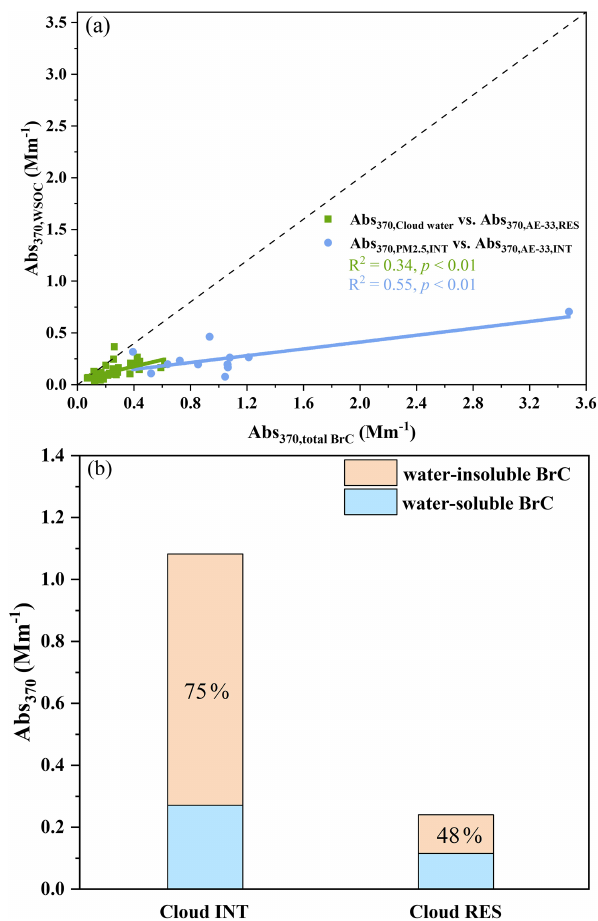
Figure 3. (a) The correlations of WSOC light absorption to total BrC light absorption in 370nm, and (b) the contribution of water- soluble BrC and water-insoluble BrC to total BrC light